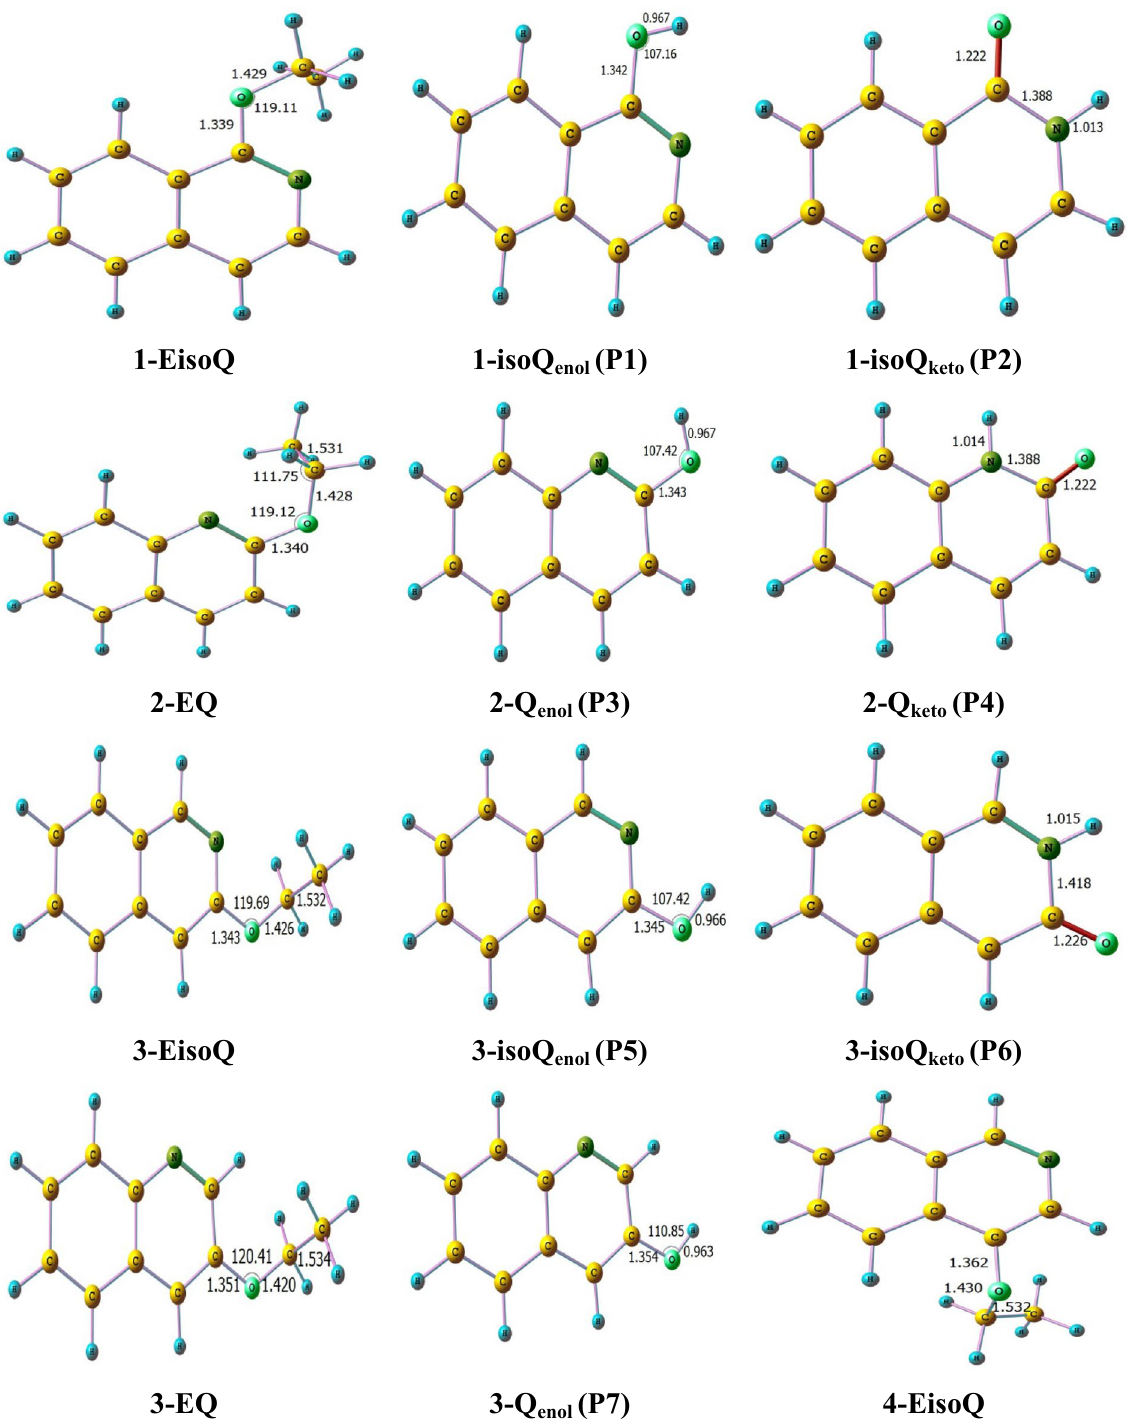
Figure 3. Optimized structures of ethoxyisoquinolines, ethoxyquinolines, and their corresponding decomposition products calculated at BMK/6–31+G(d,p) level. Bond lengths and angles are given in Ångström and degree,